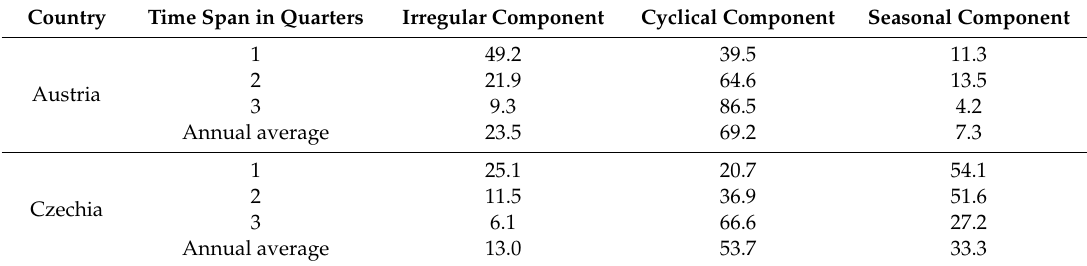
Table 3. Relative contributions of irregular, cyclical, and seasonal components to the overall price variation depending on time